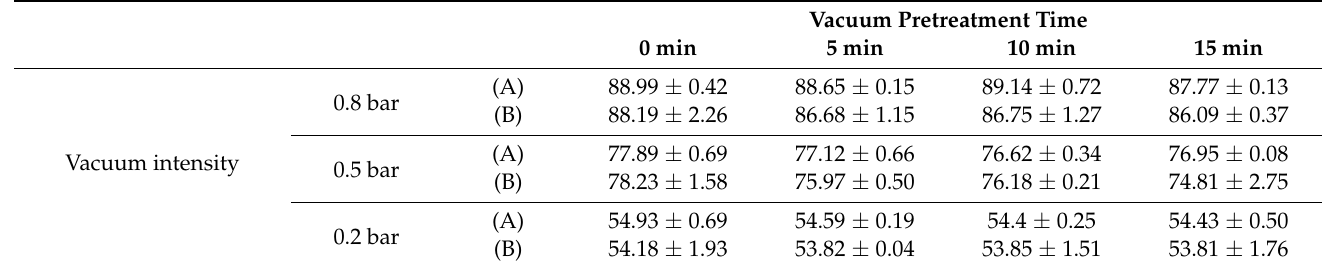
Table 3. Temperature values of model food under different ohmic heating–vacuum (OH–VC) combination heating with